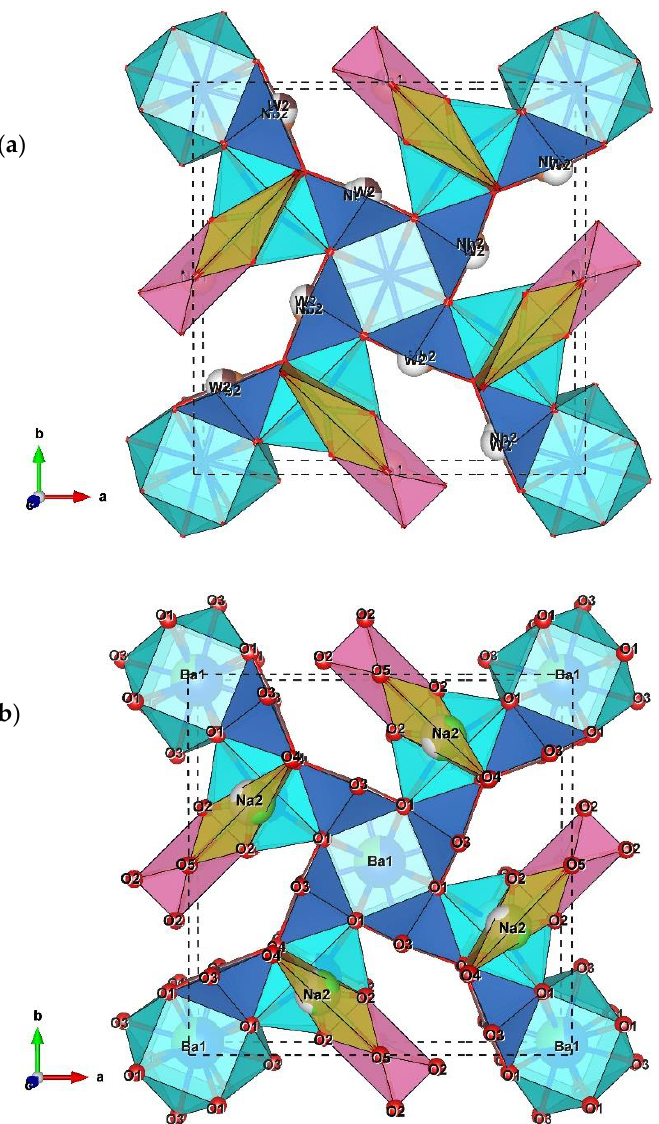
Figure 2. Crystal structure Ba 0.54 Na 0.46 Nb 1.29 W 0.37 O 5 projected along the c-axis: ( a ) Nb/W–O environment; ( b ) Ba/Na–O